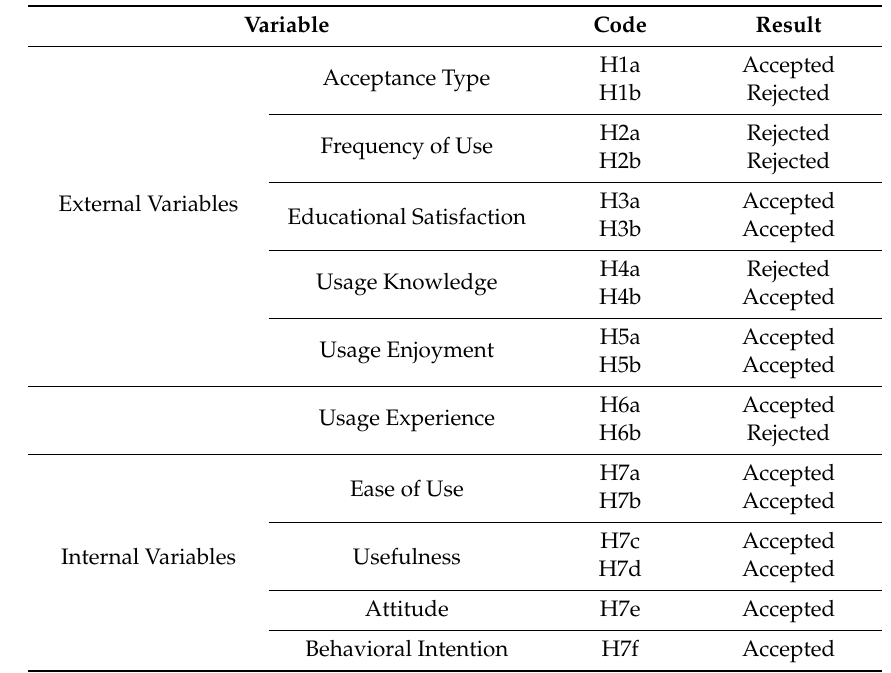
Table 1. Verification results.